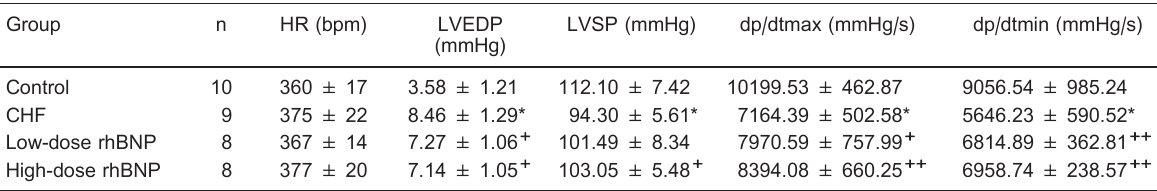
Data are reported as means±SD. HR: heart rate; LVSP: left ventricular systolic pressure; LVEDP: left ventricular end-diastolic pressure; dp/dtmax: maximal rate of rise of left ventricular pressure; dp/dtmin: maximal rate of fall of left ventricular pressure; CHF: